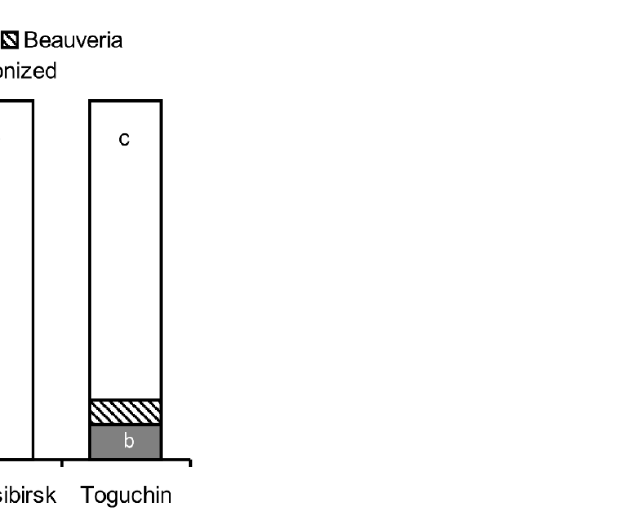
Figure 2. Isolation of Metarhizium spp. and Beauveria spp. from non-sterilized potato roots from kitchen gardens (Karasuk, Toguchin) and the conventional agrosystem (Novosibirsk) in 2020 ( n = 30 per point). Different letters indicate significant differences among locations (Fisher’s exact test, p < 0.03).